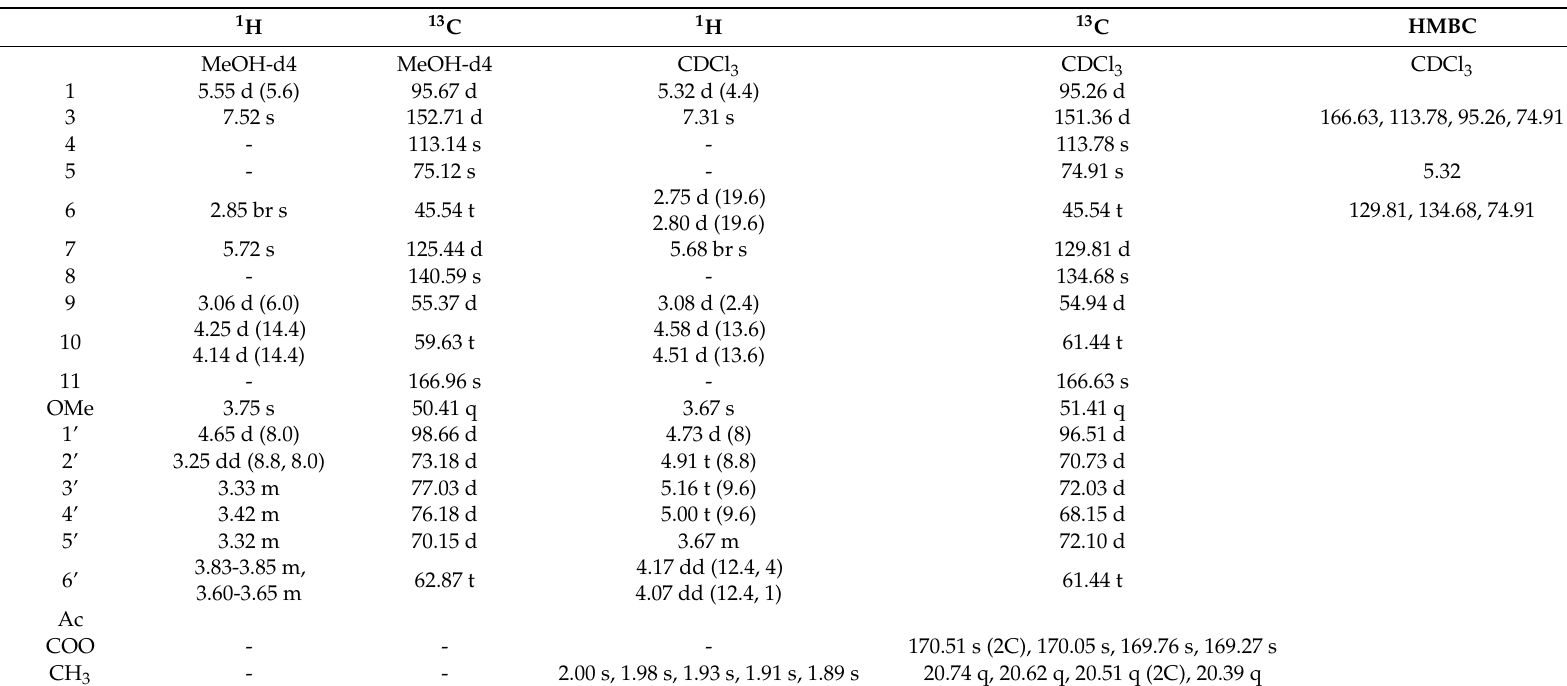
Table 2. 1 H, 13 C nuclear magnetic resonance (NMR) and heteronuclear multiple bond correlation (HBMC) data of theviridoside (compound 8 ) and its pentaacetate (400 and 100 MHz, respectively; MeOH-d4 or CDCl 3 , δ -values, J in.